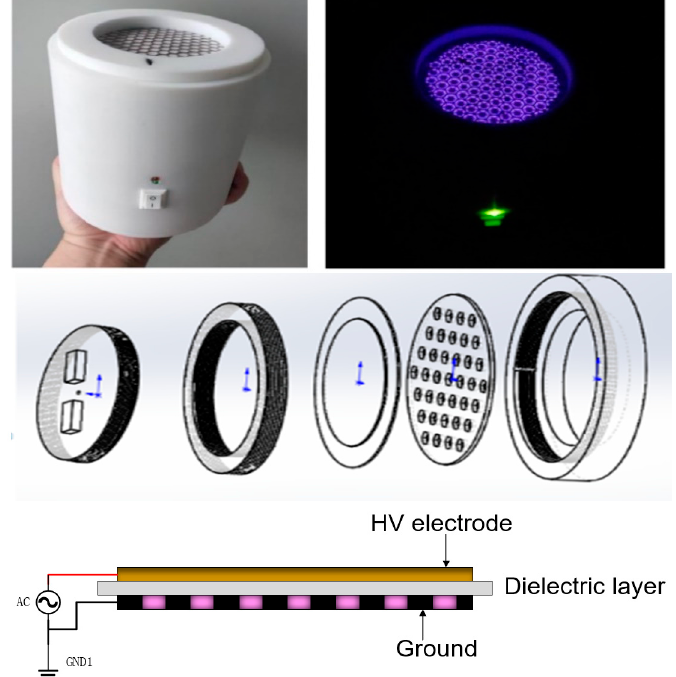
Figure 1. Portable plasma equipment